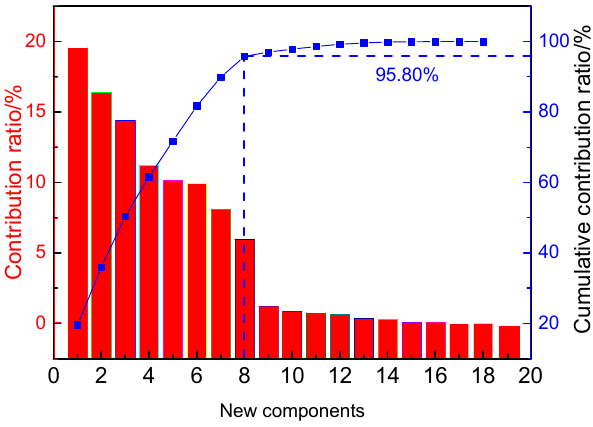
Figure 5. Contribution rate and cumulative contribution rate of new components.